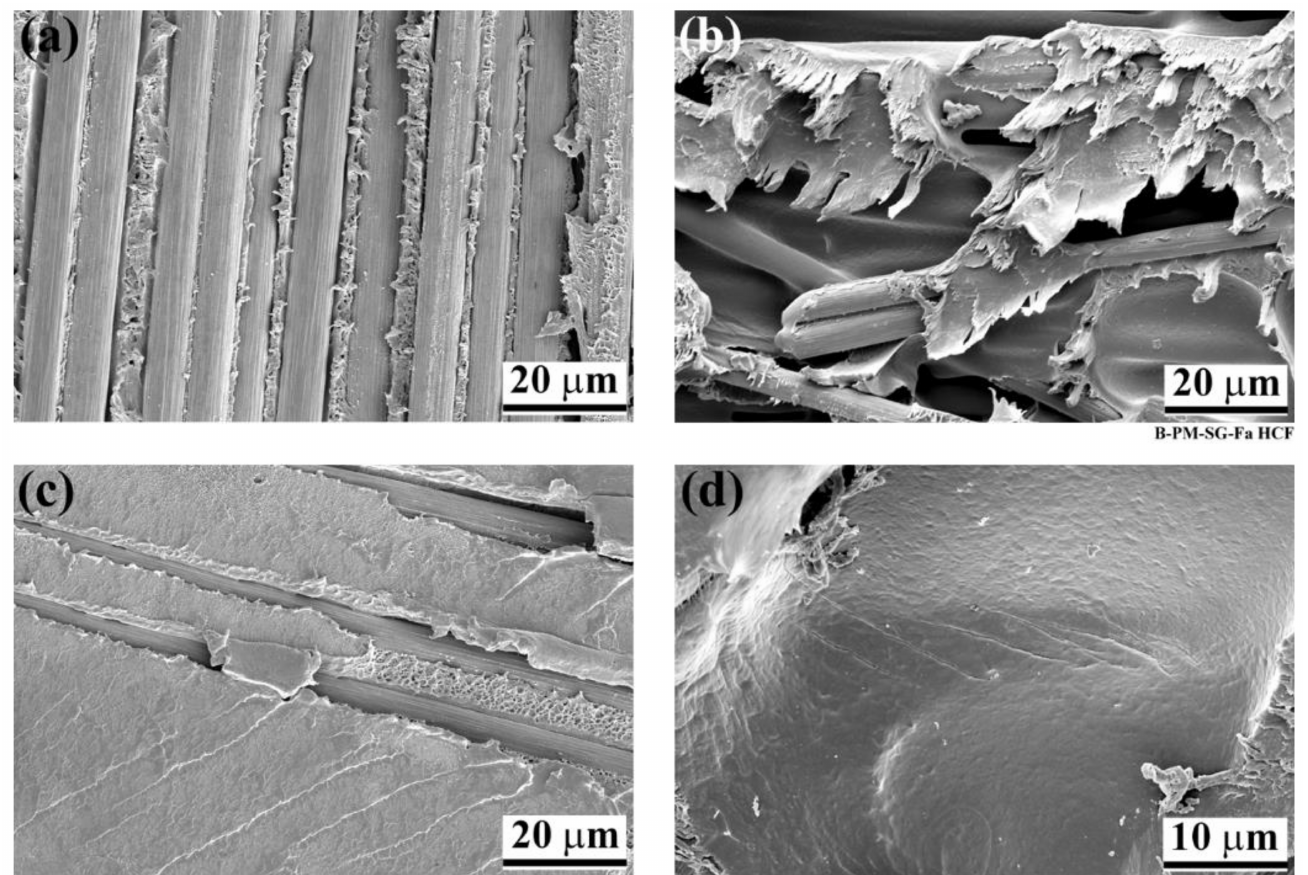
Figure 7. Failure micro-mechanisms of a high-cycle fatigue PAA-P specimen from the composite side: ( a ) warp fibers’ orientation, ( b ) weft fibers’ orientation, ( c ) fatigue striations in the PPS matrix that was detached from the aluminum, and ( d ) striations in the PPS matrix in a resin-rich area (Reprinted from [7] with permission; Copyright Springer Nature 2021). The fatigue loading direction was vertical in all